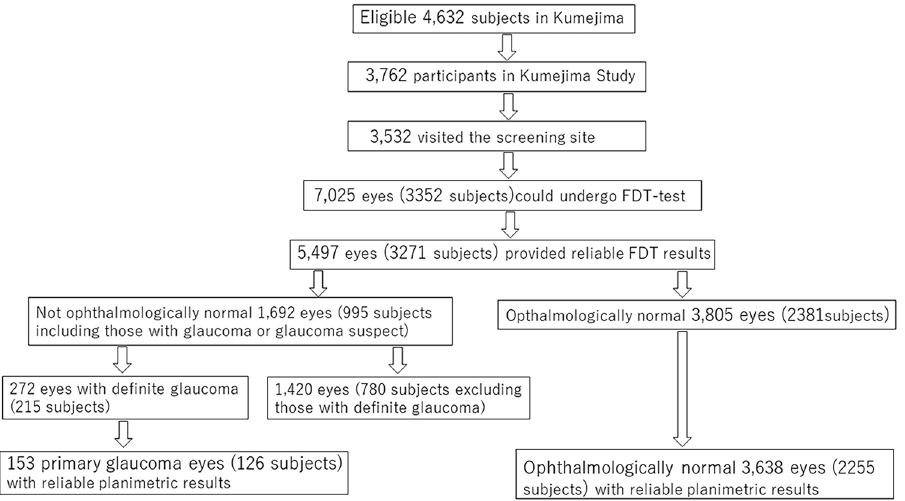
Figure 1. The process of determining the target eye of this study in the Kumejima Study is shown. Finally, 3638 normal eyes of 2255 subjects and 153 eyes with primary open-angle glaucoma or primary angle-closure glaucoma of 126 subjects were included.